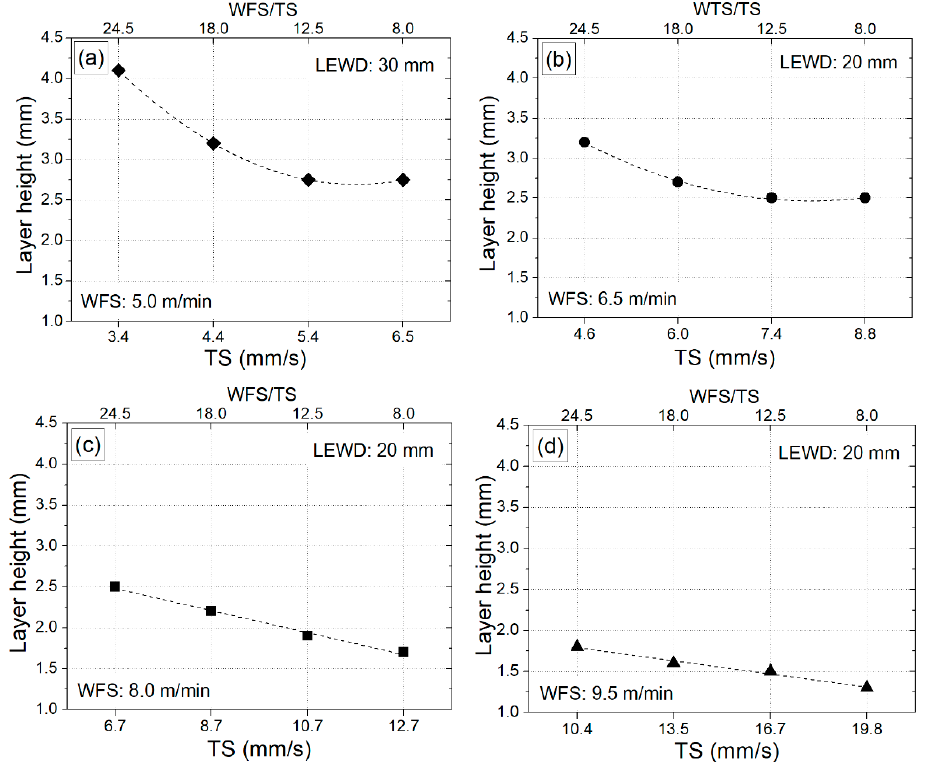
Figure 17. Layer height values according to the expanded work envelope: ( a ) WFS: 5.0 m/min, ( b ) WFS: 6.5 m/min, ( c ) WFS: 8.0 m/min and ( d ) WFS: 9.5 m/min.